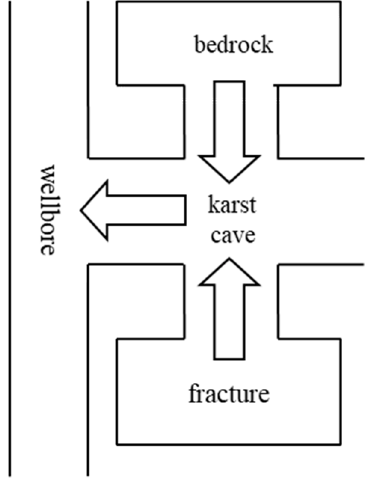
Figure 2. Triple medium reservoir model.